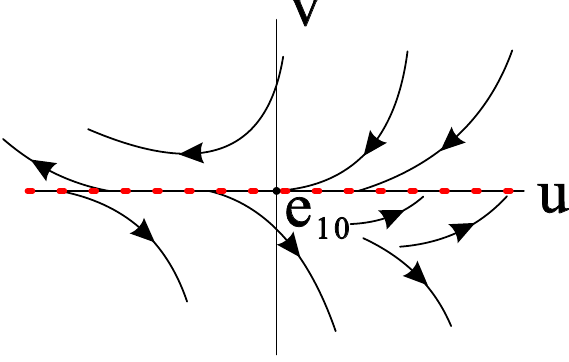
Figure 2. Local phase portrait of e 10 .